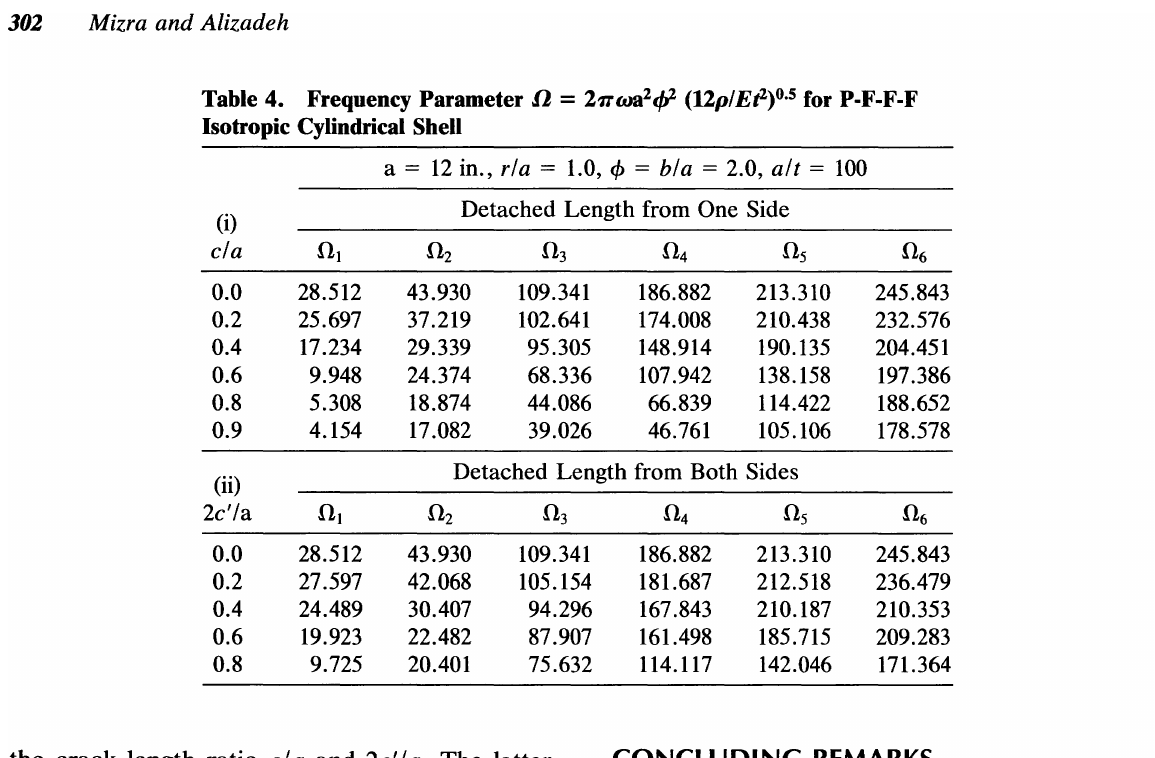
n = 2'1T(d82tf} (12pIEtl)o.s for P-F-F-F